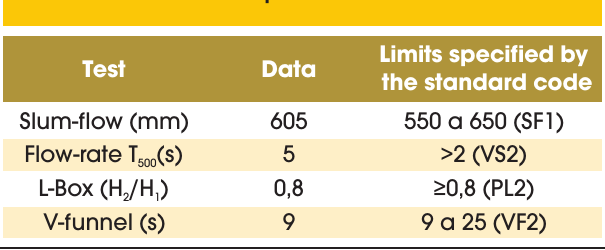
Figure 5 – Drying creep and drying shrinkage deformations for both 14 and 49 days at